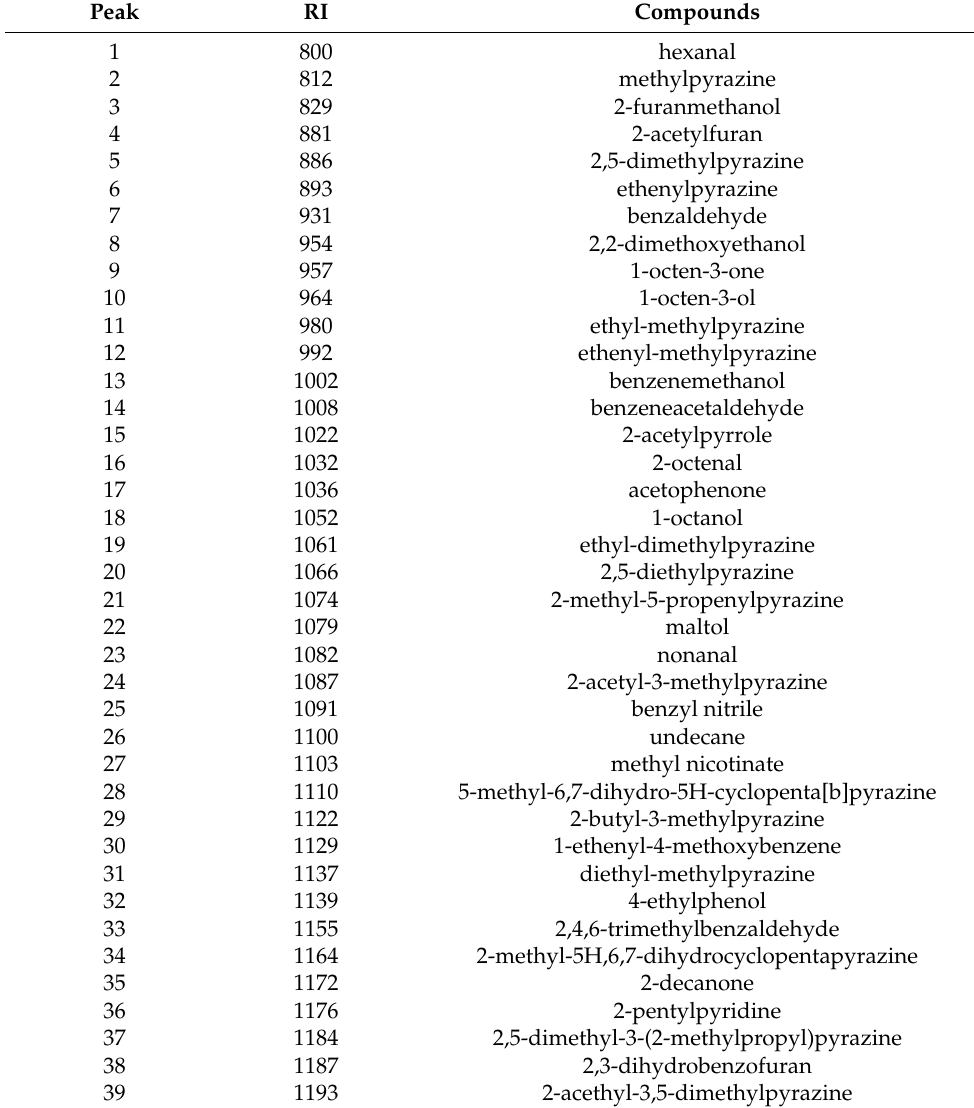
Table 4. The volatile compounds identified in peanut oil during the oxidation process via HS-SPME and GC/MS. Peak RI Compounds 1